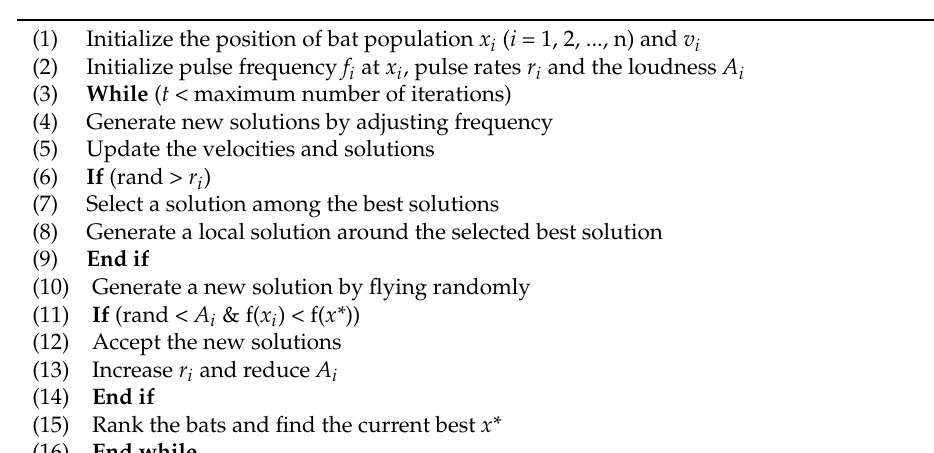
Algorithm 1. Pseudo code of the Bat Algorithm.